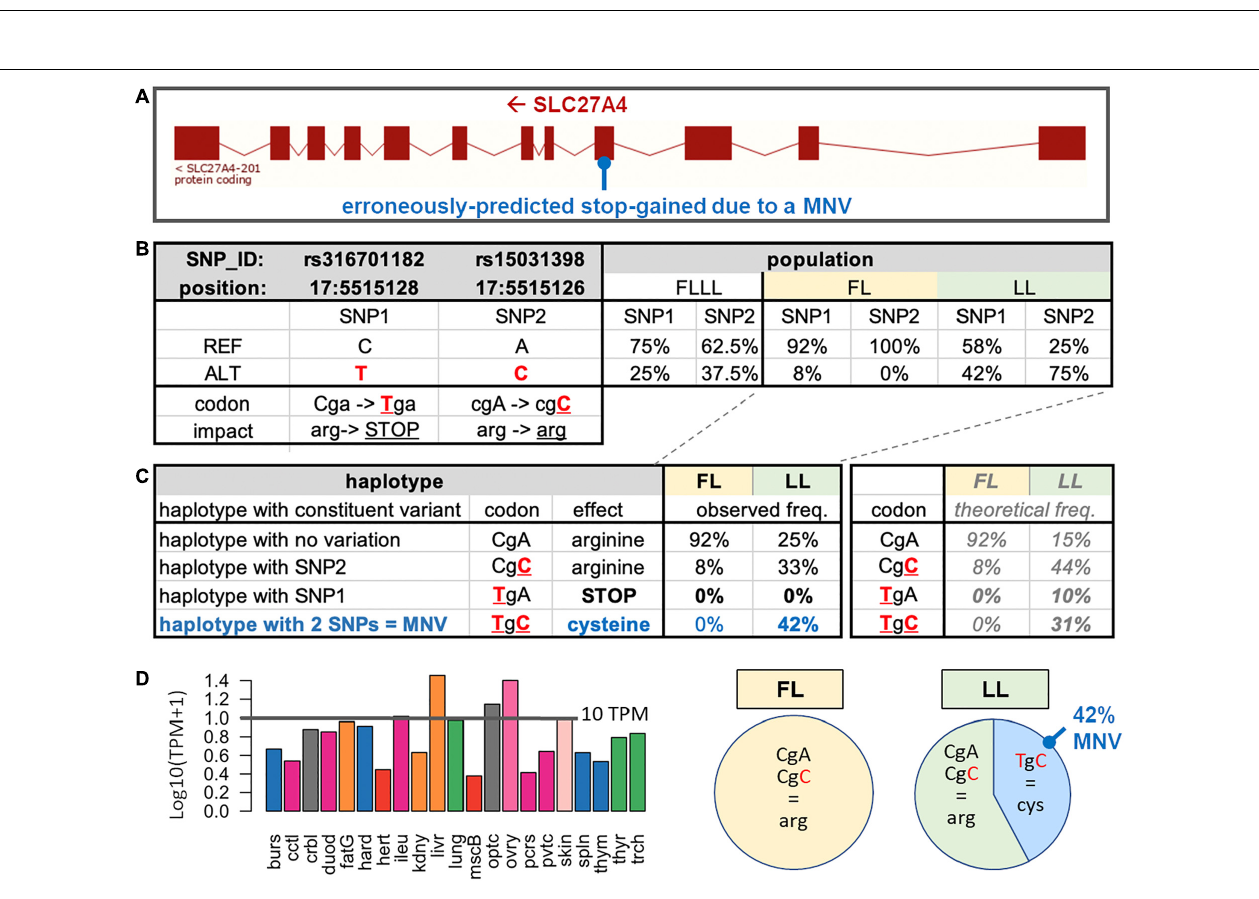
FIGURE 4 | SLC27A4 with an MNV composed of two phased SNPs observed in the experimental divergent lean line (LL). (A) Exon structure of the SLC27A4 gene and the MNV location. (B) For the two SNPs (SNP1: rs316701182 and SNP2: rs15031398) related to the MNV of interest, the allele position (on the Galgal5 genome), functional impact on the associated protein, and frequencies in the FLLL population are indicated, and the two FL and LL subpopulations are divergently selected on abdominal fat weight. (C) Effects of the four haplotypes related to SNP1 and SNP2 separately analyzed by VEP and frequencies in LL ( n = 12) and FL ( n = 12) subpopulations and focus on the percentage of observed haplotypes in the two FL and LL subpopulations. The haplotypes were determined through the IGV browser of mapped RNA-seq reads against the chicken genome. (D) Tissue expression of the gene in a chicken RNA-seq dataset composed of 21 tissues (Jehl et al.,